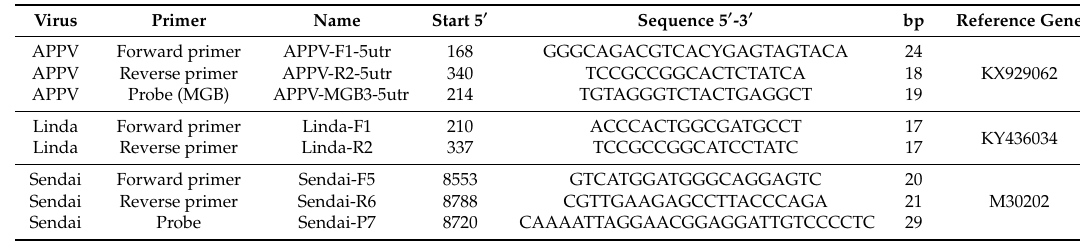
Table 1. Real-time RT-PCR primers and